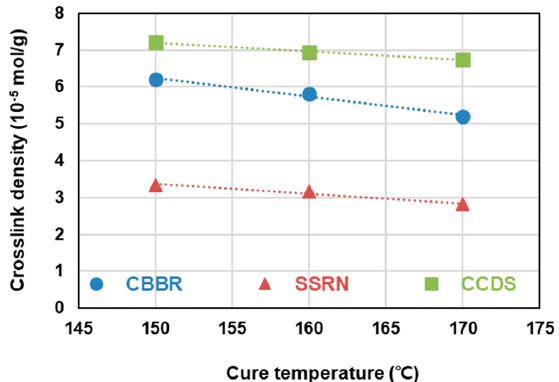
Figure 6. The decreasing rate of the crosslink density of the SBR binary filler compounds according to the cure temperatures.